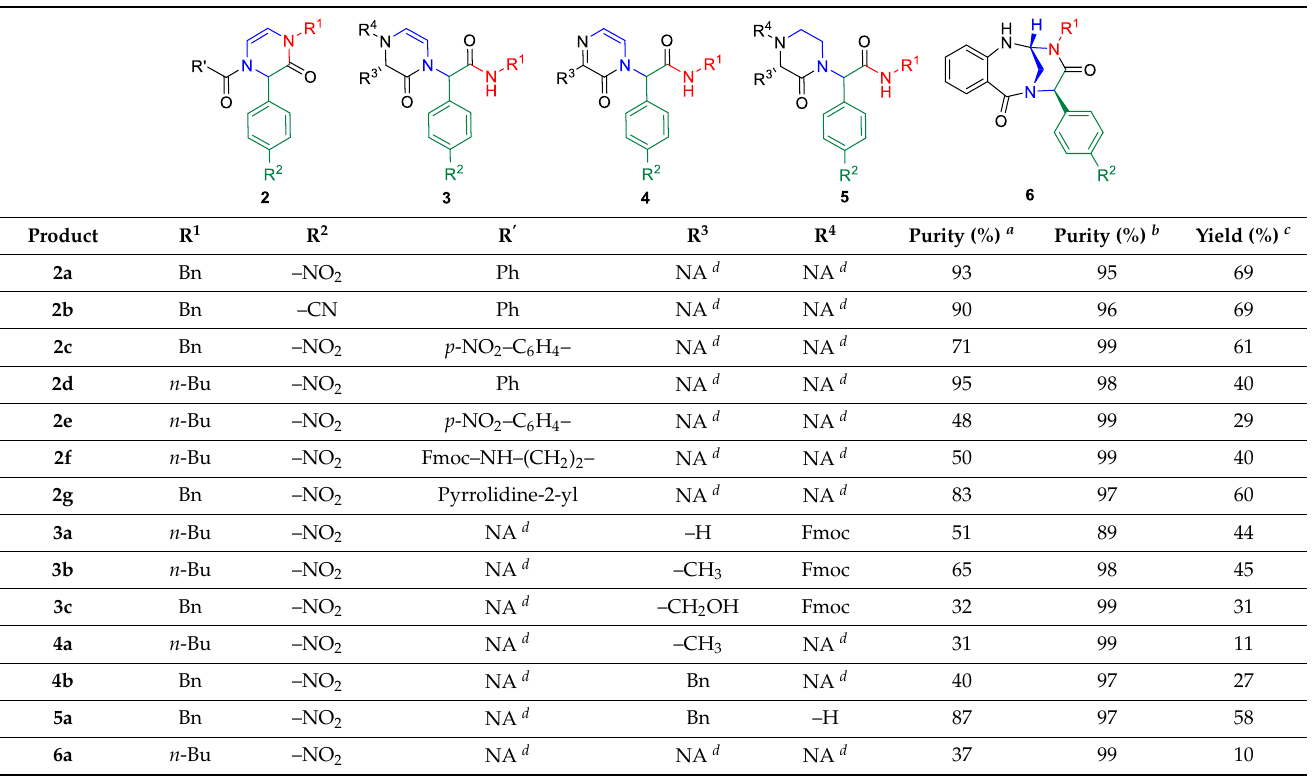
Table 1. List of synthesized and fully characterized products.